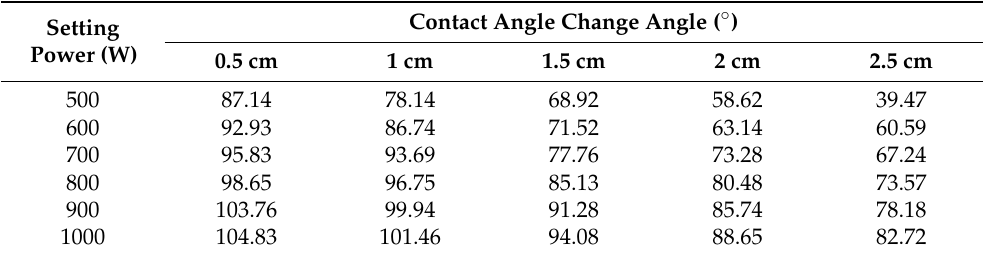
Table 5. Data table of plasma cleaning mobile phone cover